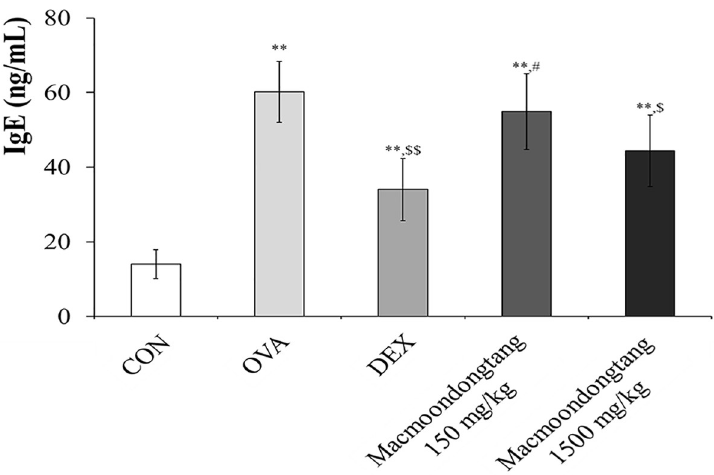
Fig 3. Macmoondongtang treatment effectively suppressed serum IgE level in a dose-dependent manner. Serum IgE level in the group treated with 1500 mg/kg macmoondongtang was compared with that of dexamethasone-treated group. Each bar represents the mean ± SD (n = 16). �� p < 0.001 vs. control; $ p < 0.05 vs. asthma induction; $$ p < 0.01 vs. asthma induction; # p < 0.05 vs. dexamethasone.